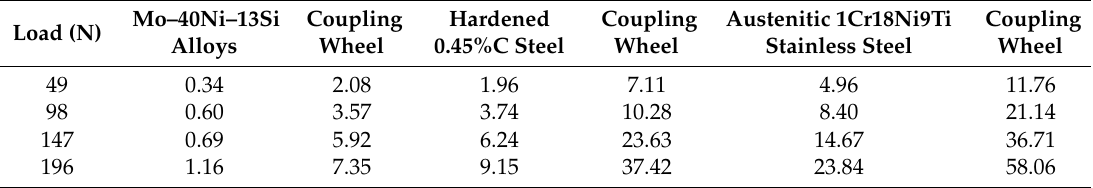
Table 2. Volumetric wear loss of block samples and coupling steel wheels under dry sliding wear conditions (mm 3 ).